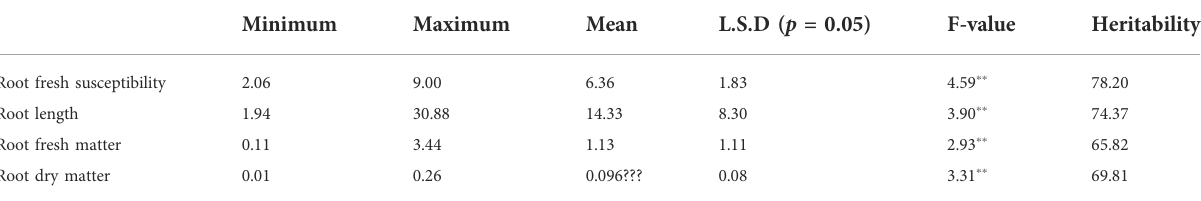
TABLE1Rangesincludingminimum,maximum,andmeanvalues,least-squaredifference,F-value,andheritabilityestimates( H 2 )forrootlength,root fresh susceptibility, root fresh matter, and root dry matter of faba bean genotypes evaluated under frost conditions.